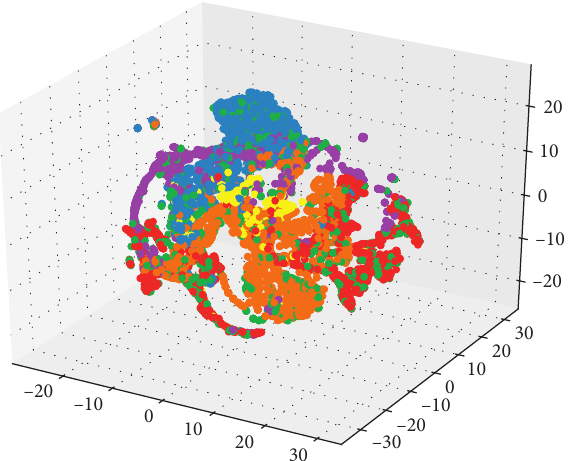
Figure 7: Classification results of train operation conditions.